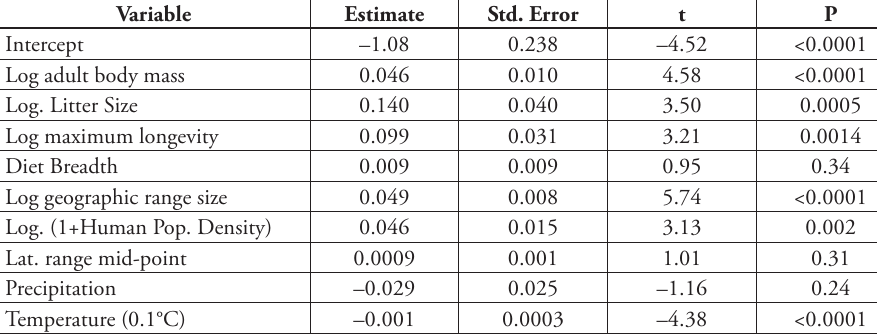
Table 5. The full phylogenetic generalised logistic model based on the significant variables in Table 4. The estimate and standard error for temperature are based on units of 0.1°C. Nagelkerke’s R 2 = 0.30; N = 704, maximum likelihood estimate of Pagel’s lambda = 0.32.